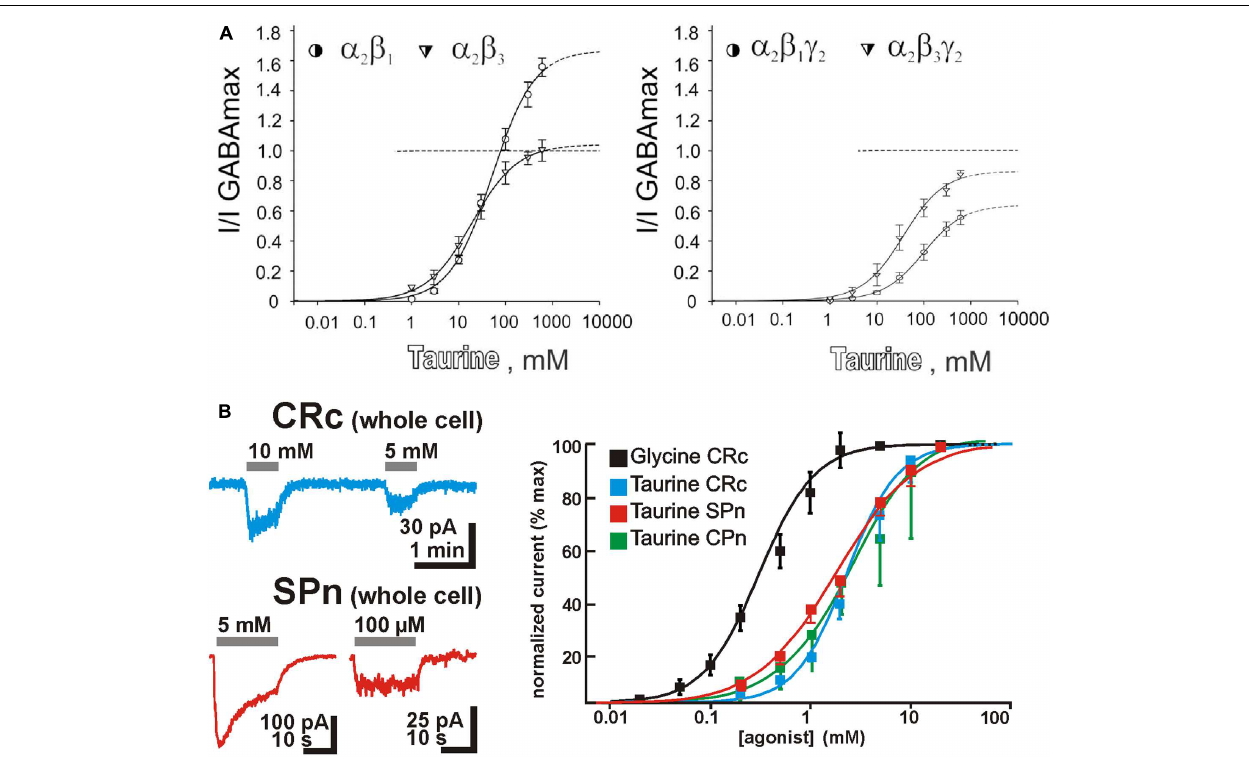
FIGURE 2 | Properties of taurine receptors. (A) Taurine affinities and maximal taurine currents critically depend on the subunit composition of GABA A receptors (modified with permission from Kletke et al., 2013). (B) Typical membrane currents and dose–response curves of taurine on glycine receptors for different neuron populations in the immature neocortex revealed that taurine is a low-affinity agonist with comparable affinities in CRc (blue), SP neurons (SPn, red), and neurons from the CP and developing layers (CPn, green) (modified with permission from Kilb et al., 2002,